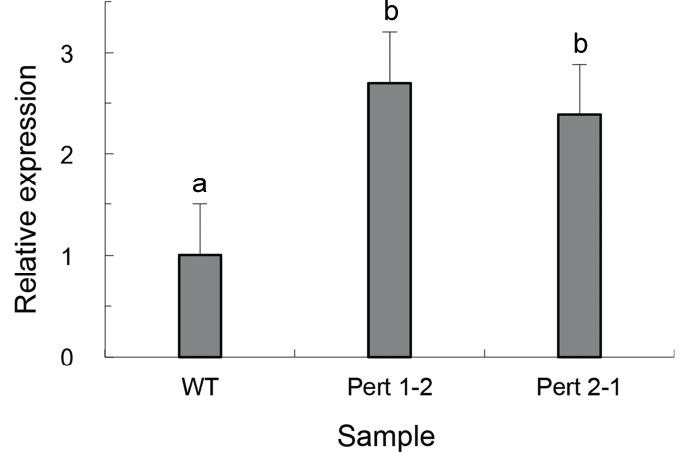
Figure 4. Expression of Per3 in HL-1-1 transformants as assessed by quantitative real-time PCR. Note: WT: Wild type. Error bars indicate the standard deviation of three replicates. Different letters represent significant differences ( p < 0.05) according to Duncan’s multiple range